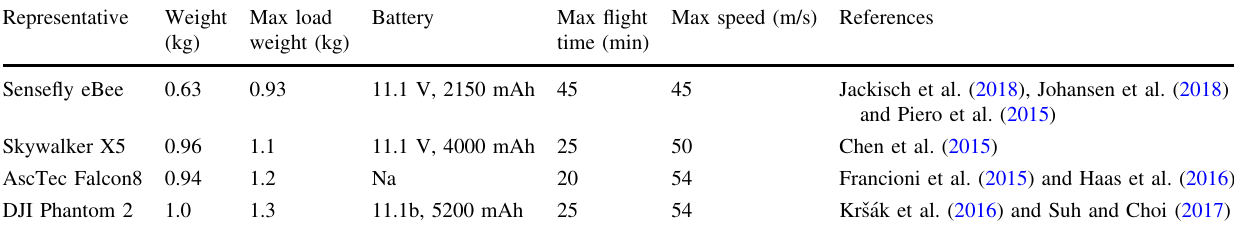
Table 2 Specifications of UAV platforms in Fig. 3 Representative